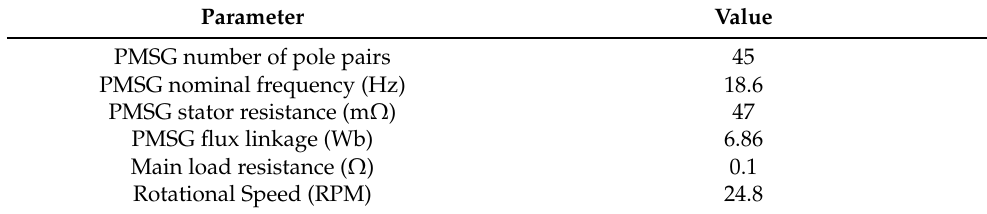
Table 1. Simulation Parameters